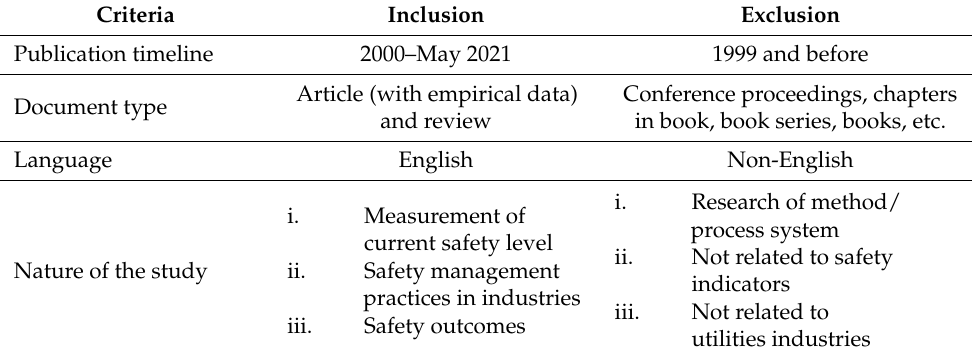
Table 2. The inclusion and exclusion